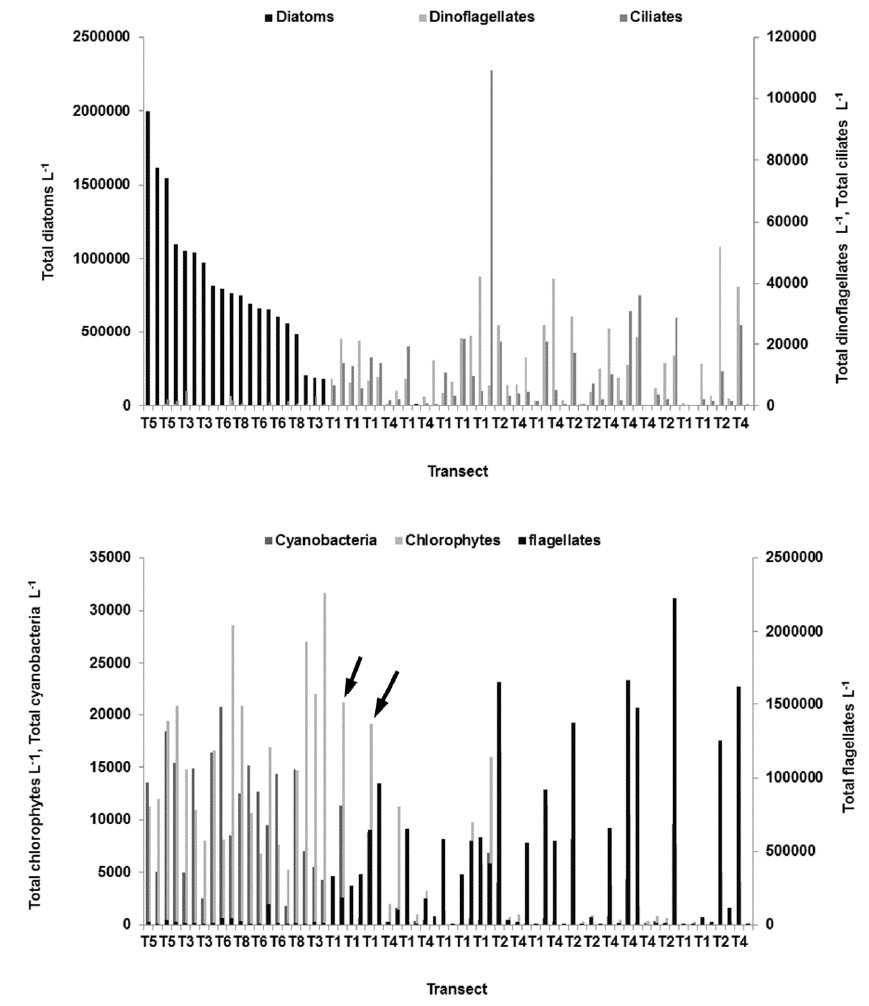
Fig. 7. Abundance of the principal plankton groups at all stations and transects: (a) diatoms (black bars), dinoflagellates (light grey bars), ciliates (dark grey bars); (b) flagellates (black bars), cyanobacteria (dark grey bars) and chlorophytes (light grey bars). Stations were sorted along decreasing diatom abundance, which gave rise to a grouping of the Lena Delta sites followed by the coastal sites. Data are shown across the whole data set, i.e. including both surface and subsurface samples, n = 66. Arrows are pointing to coastal stations on T1 with particularly high numbers of